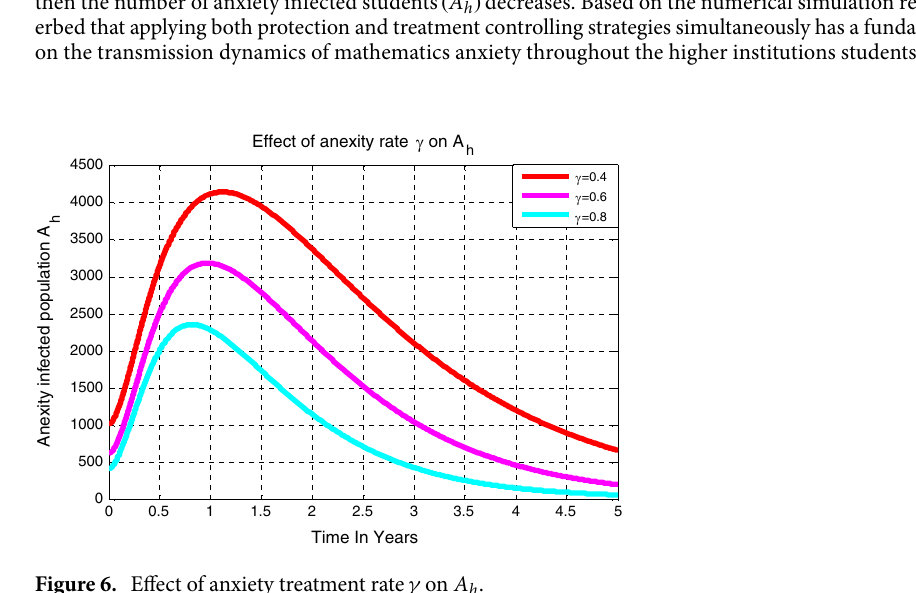
Figure 6. Effect of anxiety treatment rate γ on A h